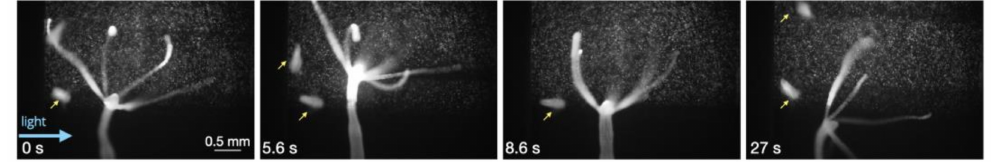
Figure 3. Baseline behaviors (bending and tentacle movement) during static conditions. Yellow arrows point to Artemia franciscana nauplii that were ignored by the Hydra after capturing 3 nau- plii